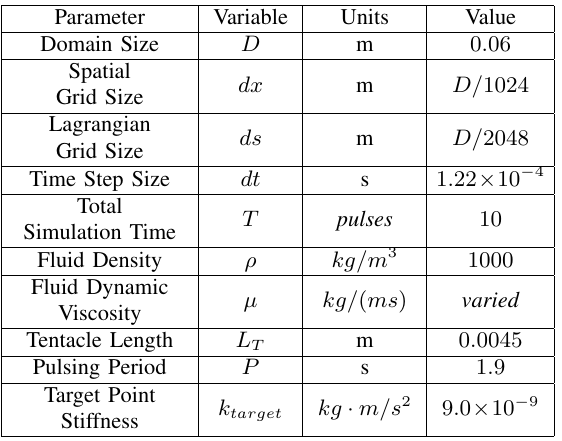
TABLE I: Numerical parameters used in the three- dimensional